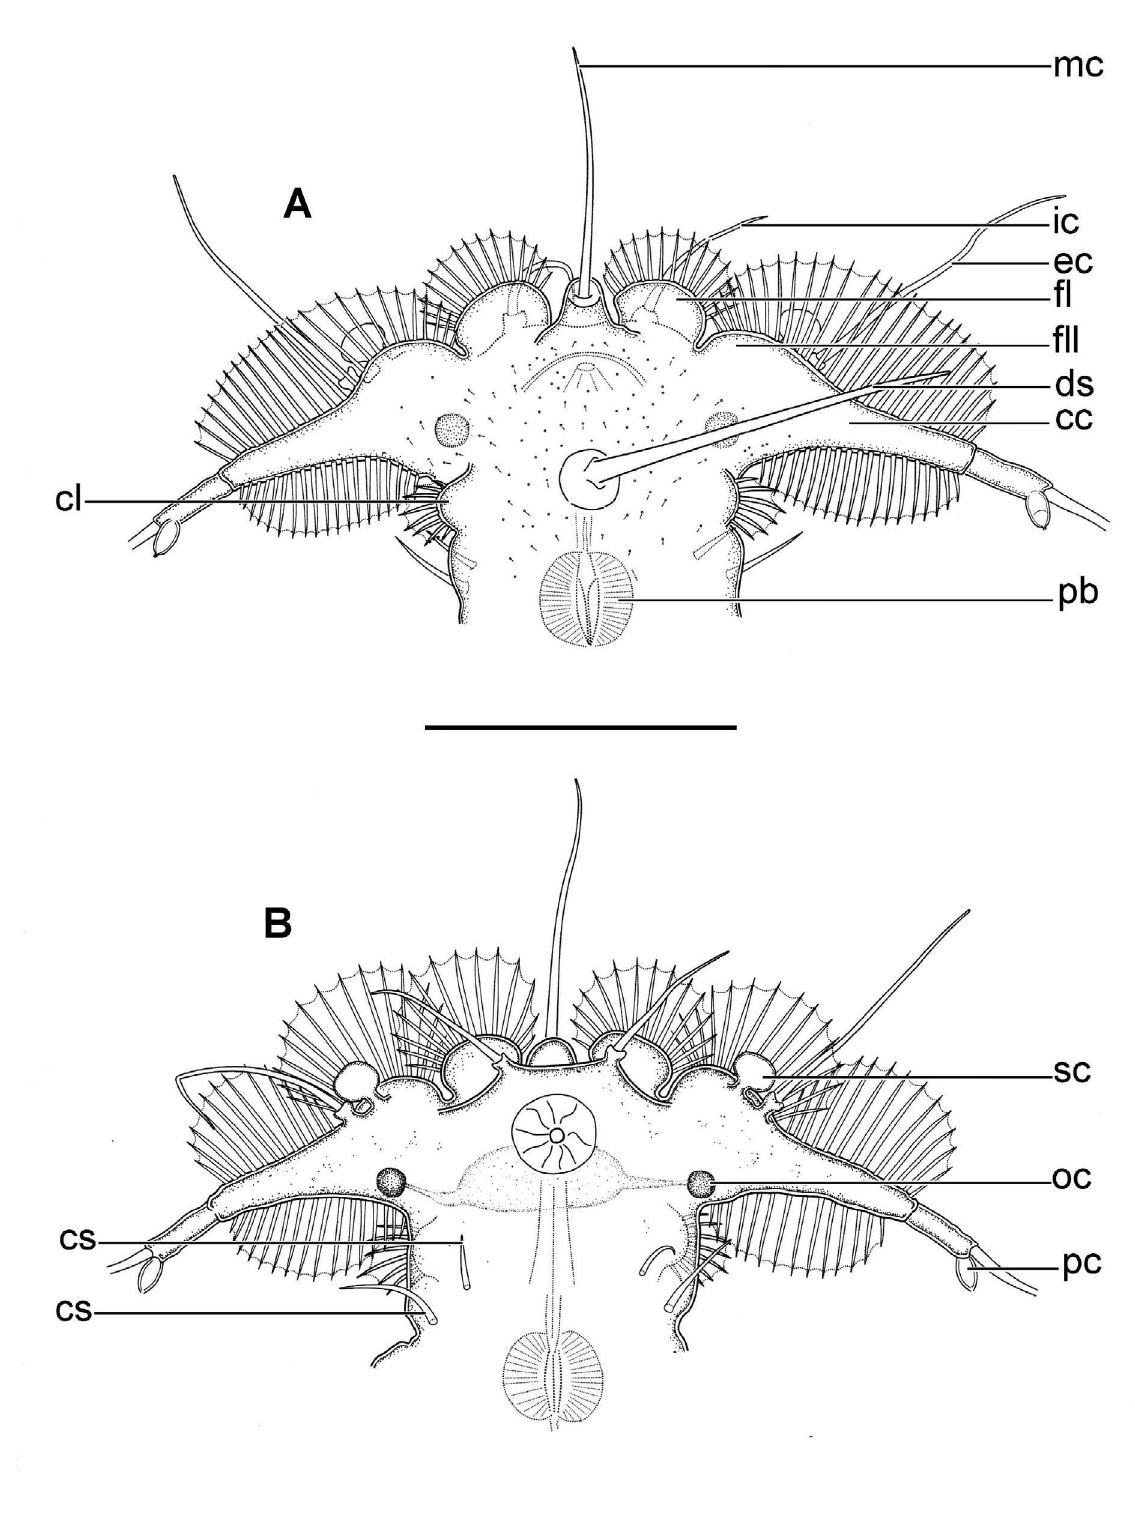
Fig. 3. Neostygarctus grossmeteori sp. nov., heads. A . Holotype, ♀ (SMF 51), dorsal view. B . Paratype, ♀ (SMF 52), ventral view. Scale bar = 50